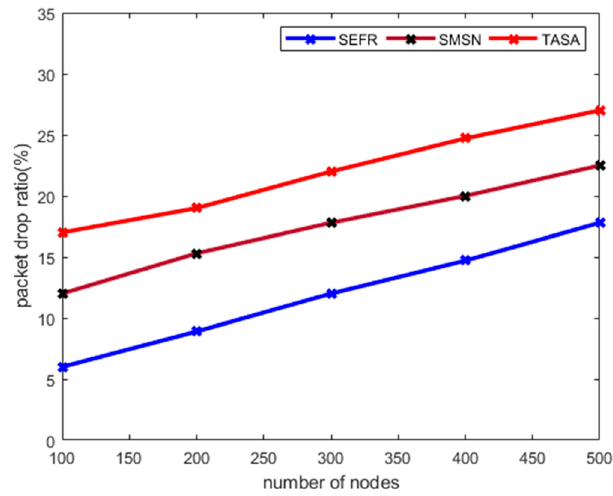
Figure 3. Packet drop ratio with varying number of nodes.